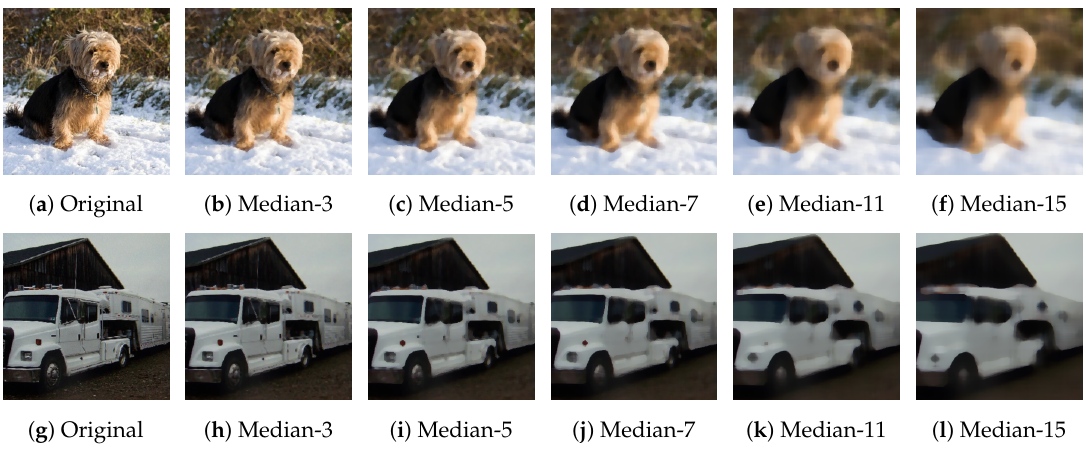
Figure 6. Various kernel size effect comparison.